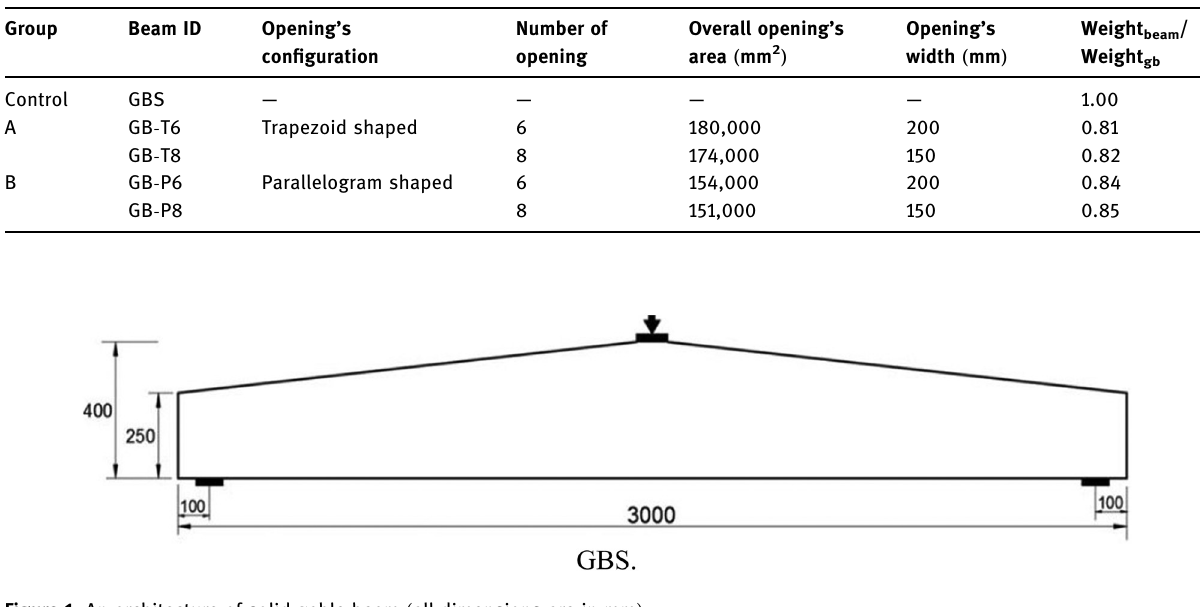
Figure 1: An architecture of solid gable beam ( all dimensions are in mm ) .